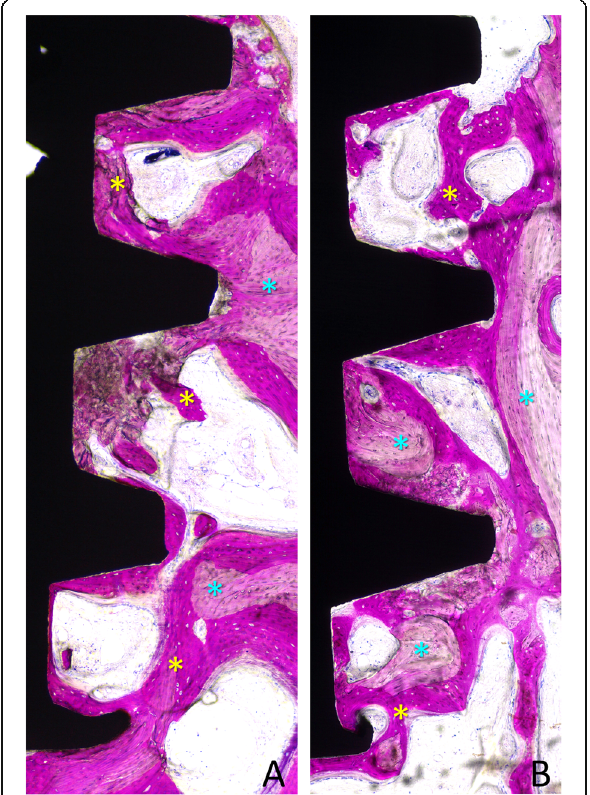
Fig. 7 a , b Photomicrographs of ground sections of devices installed with insertion torque ~ 30 Ncm. Note newly formed bone (yellow stars) and pre-existing old bone (light blue stars). Originally grabbed at × 100 magnification. Acid fuchsine and toluidine blue the present study that reported ~ 10% of more mineral- ized bone at the ~ 30 Ncm compared to the < 10 Ncm torque. In another experiment [1], the healing at implants in- stalled in the mandible of sheep using the torque of ~ 10